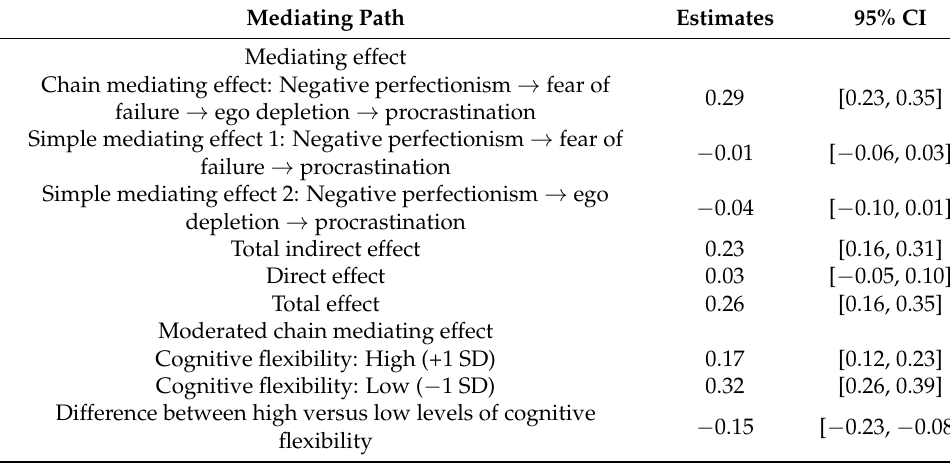
Table 4. Analyses of the mediating